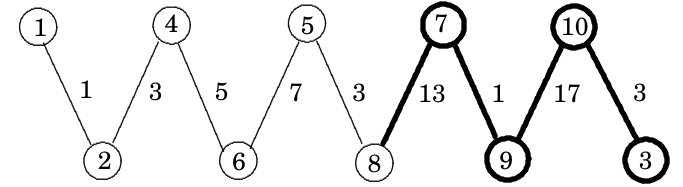
Figure 4: The construction of the rainbow mean coloring c